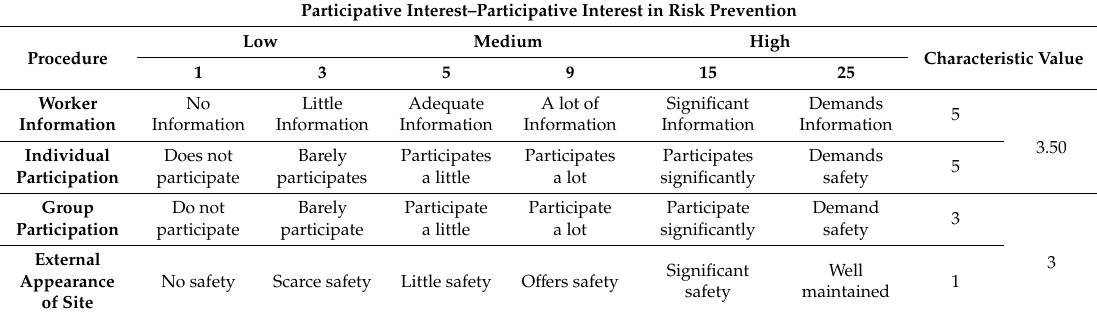
Table 8. Example of characteristic value in Participative